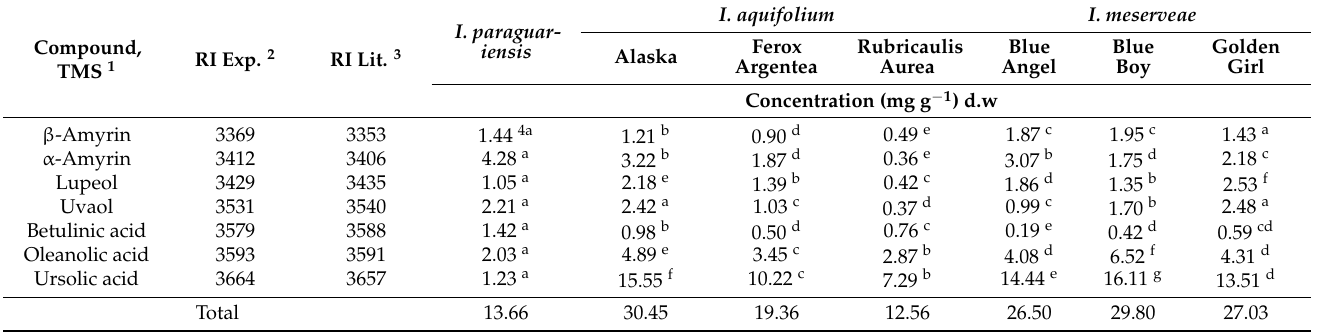
Table 2. Profile of triterpenoids in I. paraguariensis and various varieties of I. aquifolium and I. meserveae